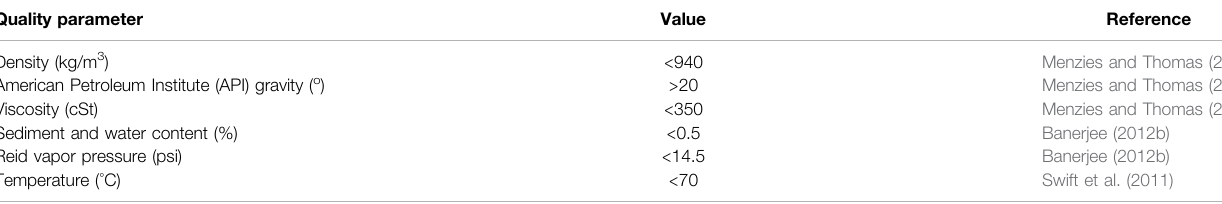
TABLE 1 | Key factors for pipeline speci fi cations for diluted bitumen.